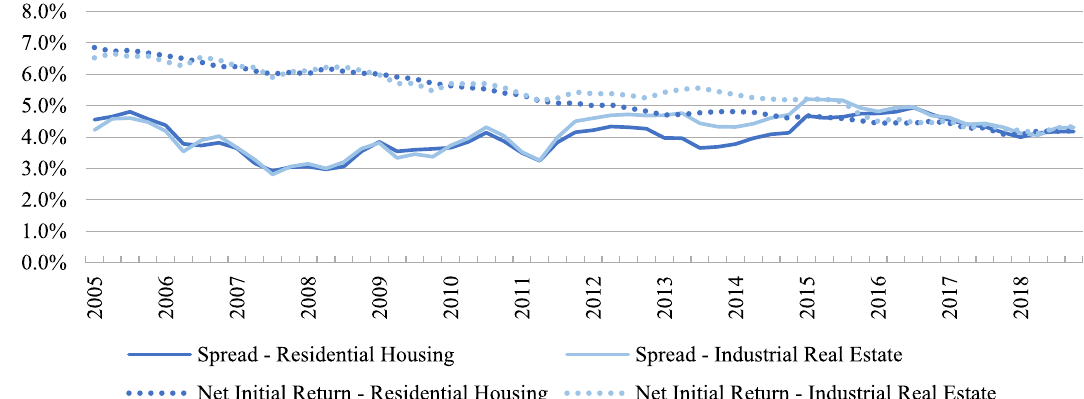
Fig. 3 Net initial returns and the spread. Notes : Net initial returns ( source : Wüest Partner AG) comprise yearly returns, whereas real estate specific costs, such as refurbishment or running costs, have been deducted. Net initial returns are available for residential housing and industrial real estate. The spread for residential housing and industrial real estate has been calculated in subtracting yields on governmental bonds with 10-year maturity ( source : data.snb.ch) from net initial returns of the respective real estate segment. The displayed time frame ranges from 2005 Q1 to 2018